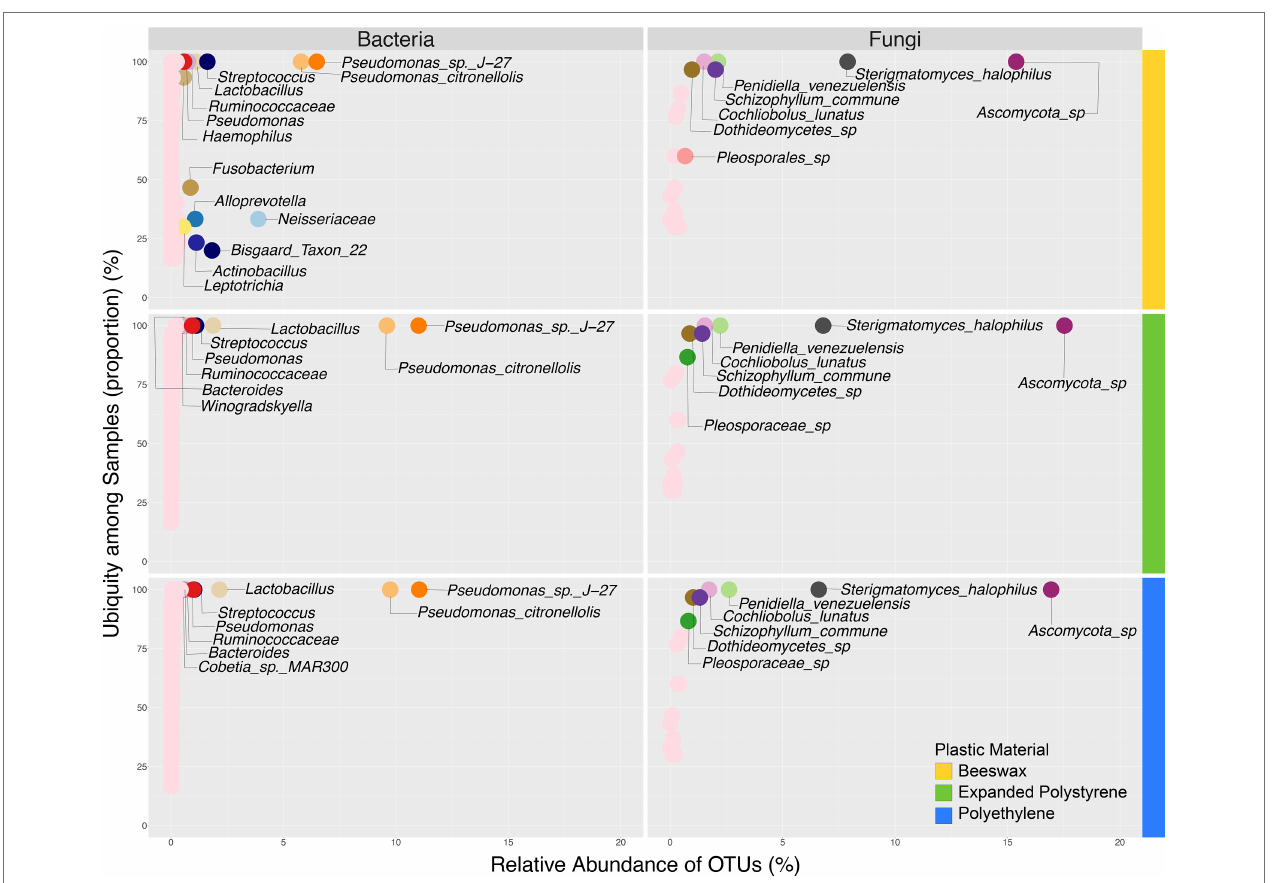
FIGURE 3 | Ubiquity analysis of both bacterial and fungal biomes comparing relative abundance against prevalence in samples based on plastic material used for